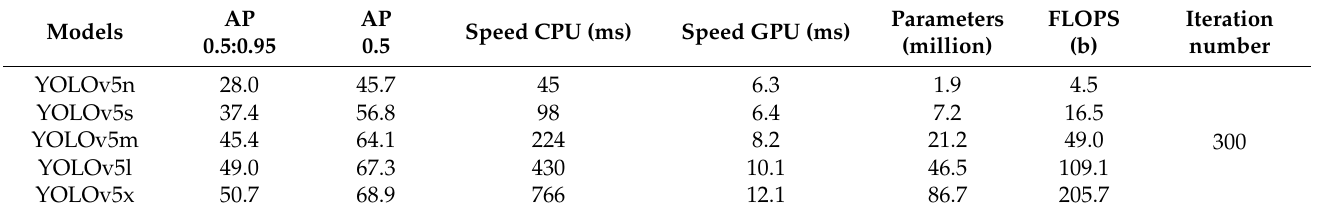
Table 5. Description of YOLOv5